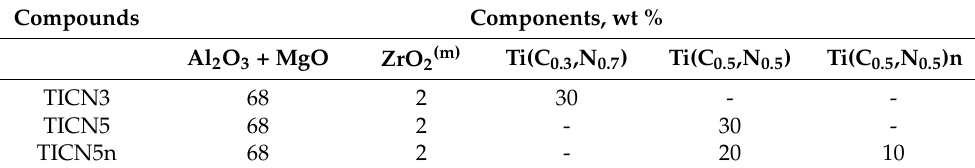
Figure 2. SEM image of commercially available powders: ( a ) Ti(C 0.5 ,N 0.5 ); ( b ) Ti(C 0.5 ,N 0.5 )n. The monoclinic phase of zirconia in microsize ZrO 2(m) (Fluka, Buchs, Switzerland) with a mean particle size of 0.4 µ m was added in the amount of 2 wt %. A small amount of sintering additives, such as MgO, to inhibit grain growth was also used. The phase composition of the tested compounds is presented in Table 1. Table 1. Composition of